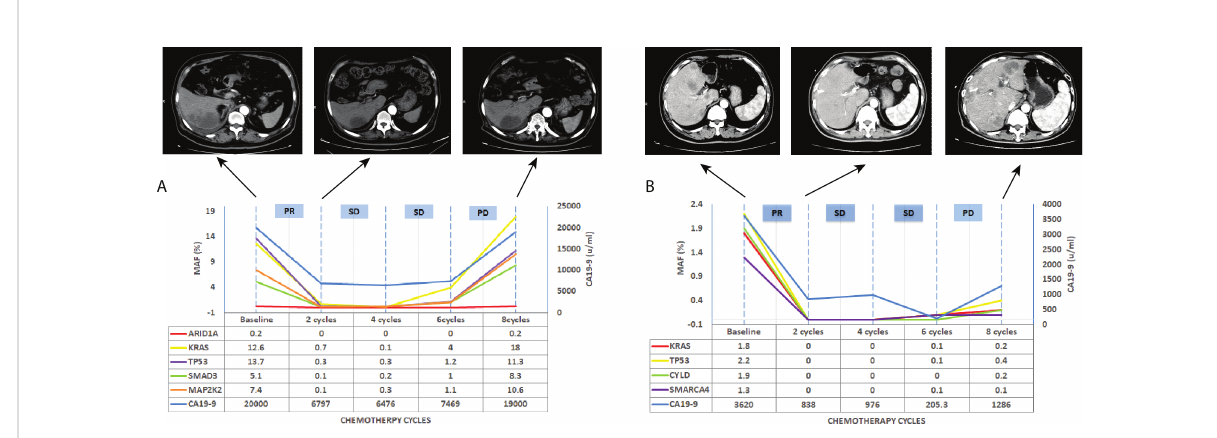
FIGURE 6 Longitudinal ctDNA analysis, CA19-9 value and CT scan for disease progression monitoring. (A) CT scan, CA19-9 value and MAF of ctDNA detection for patients A, (B) CT scan, CA19-9 value and MAF of ctDNA detection for patients B. MAF, mutation allelic frequency; PR, partial response; SD, stable disease; PD, progressive